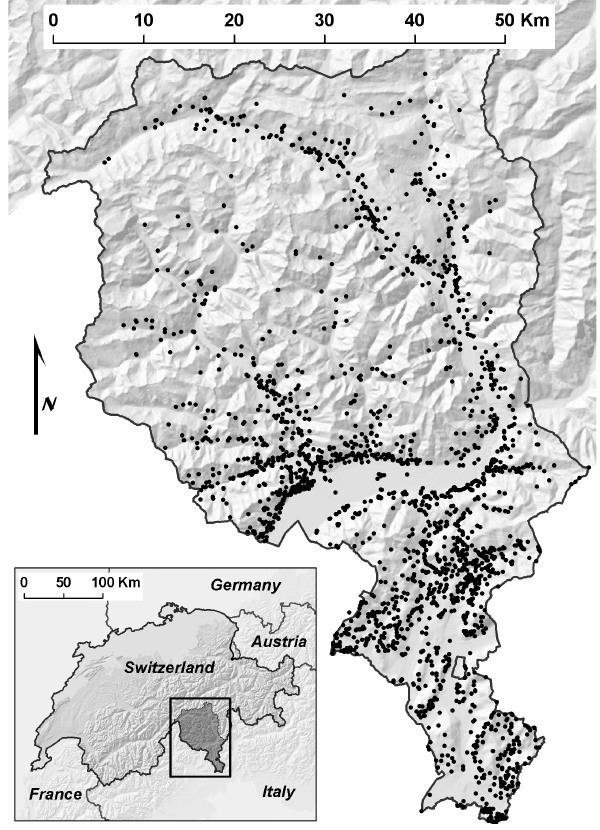
Fig. 1. The study area. Black dots represent the ignition points of the considered forest fires.